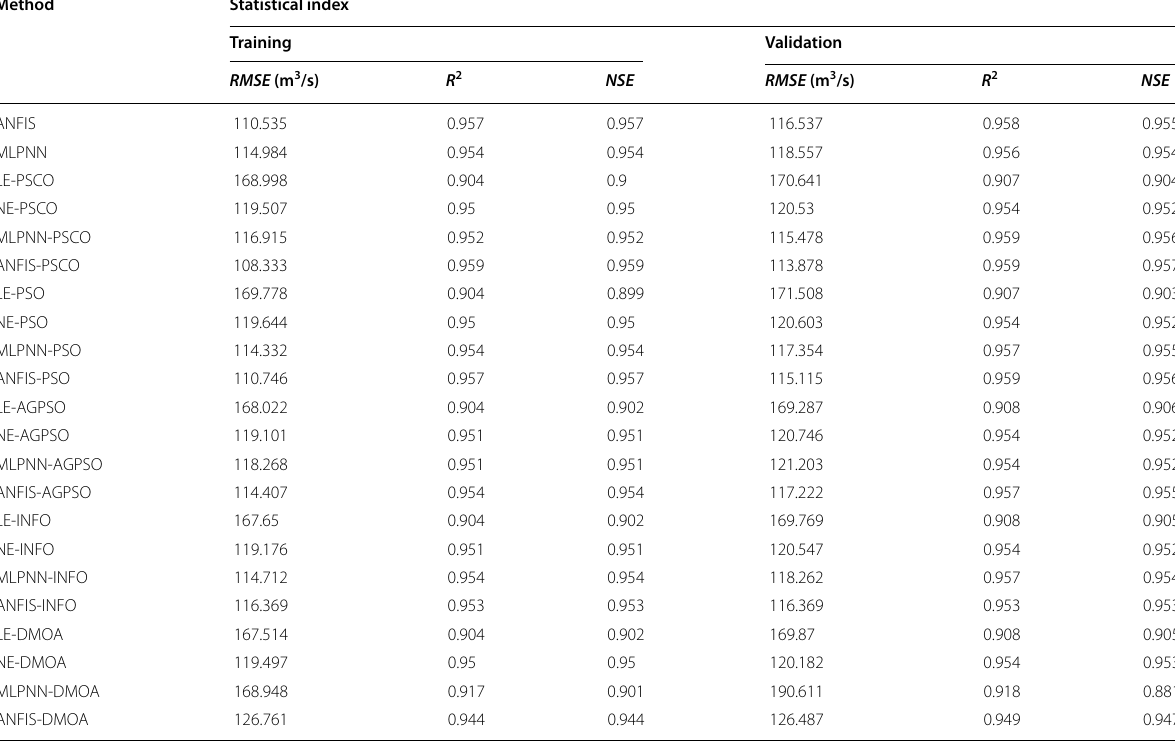
Table 6 Results obtained in training and validation